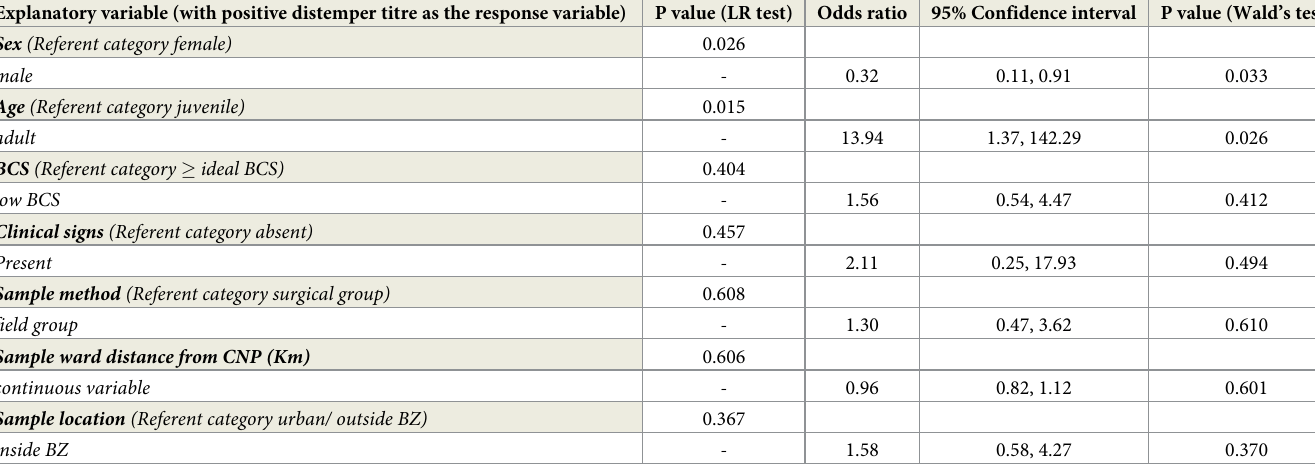
Table 2. Association of variables with CDV seropositivity. Explanatory variable (with positive distemper titre as the response